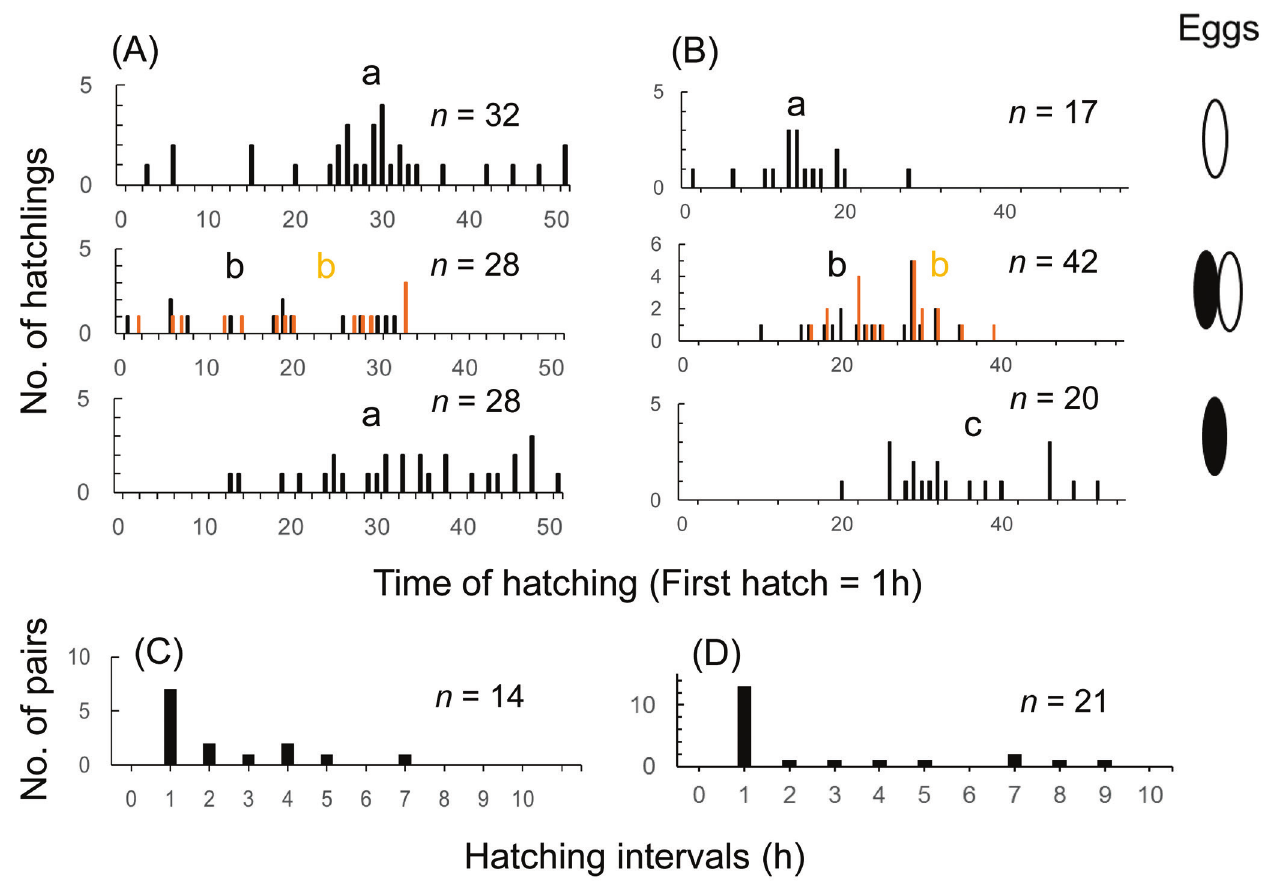
Fig. 13. Hatching patterns of Locusta migratoria eggs derived from different pods that were kept singly on day 10 and paired in contact with each other on day 12. Some eggs from the respective pods were singly kept as controls. Two pods laid on the same day ( A ) and different days ( B ) were used. In the mixed pairs (middle panel), the first and second hatchings are shown in black and light-colored bars. Different lower-case letters indicate significant differences in mean values at the 5% level with Tukey’s multiple test. The diagrams on the right of the figure show combinations of eggs from two pods expressed as white and black eggs, respectively. The frequency distributions of hatching intervals for the mixed pairs are shown ( C and D